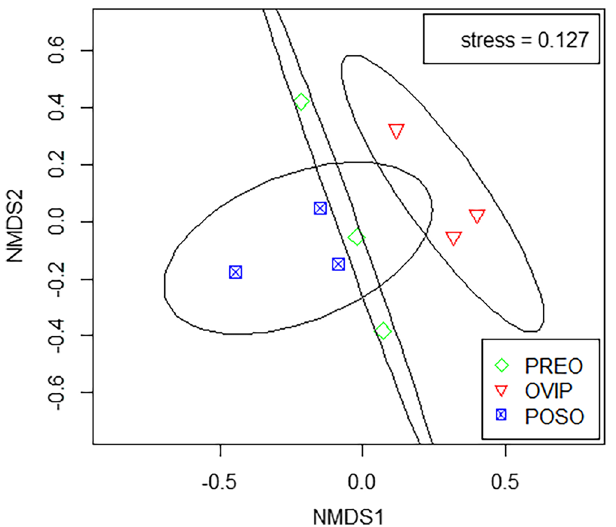
Figure 2. Multivariate analysis of the volatiles from fresh feces of Przewalski’s horse at the stages of PREO, OVIP, and POSO of Gasterophilus pecorum by the non-metric multidimensional scaling (NMDS) method. PREO, OVIP, and POSO represent fresh feces at the stages of pre-oviposition, oviposition, and post-oviposition of Gasterophilus pecorum ,